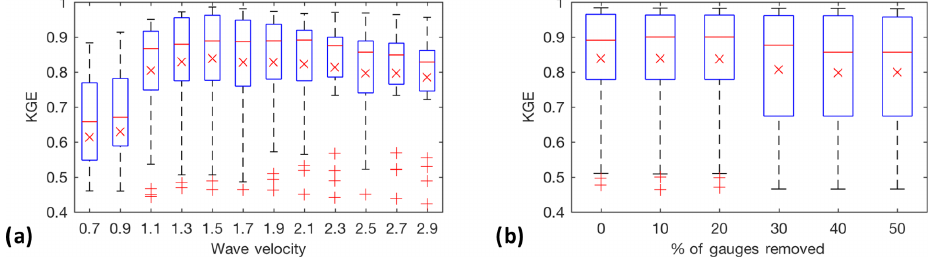
Figure 9. Box plots of KGE values at 25 validation sites for two sensitivity experiments: (a) varying wave velocity parameters, (b) removing gauges from the observation set. In each of these experiments the null initial condition was used. The mean of each set is denoted with a red X.